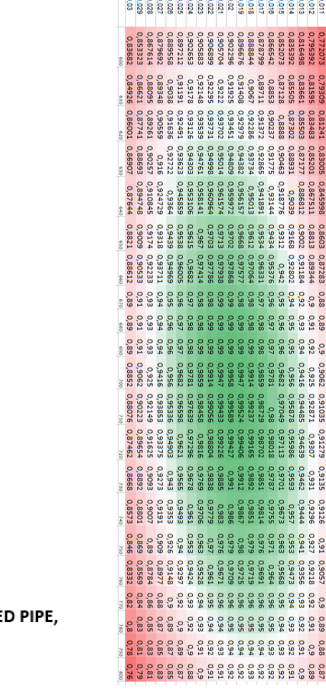
Figure 3. The response surface ( left ) and Excel–nomogram ( right ) determine the optimum when implementing a composite full–factor experiment when fixing the height of the seed pipe in the center of the plan at the level of 0.2 m. 4. Discussion A central compositional uniform rotatable plan of the second order was used to plan the full ‐ factor experiment. One of the accuracy characteristics of the regression model is the variance of the 𝑠 (cid:2870) (cid:4668)𝑦̑(cid:4669) response values predicted by the regression equation. The rotatability property of the plan means that the accuracy of the regression equation